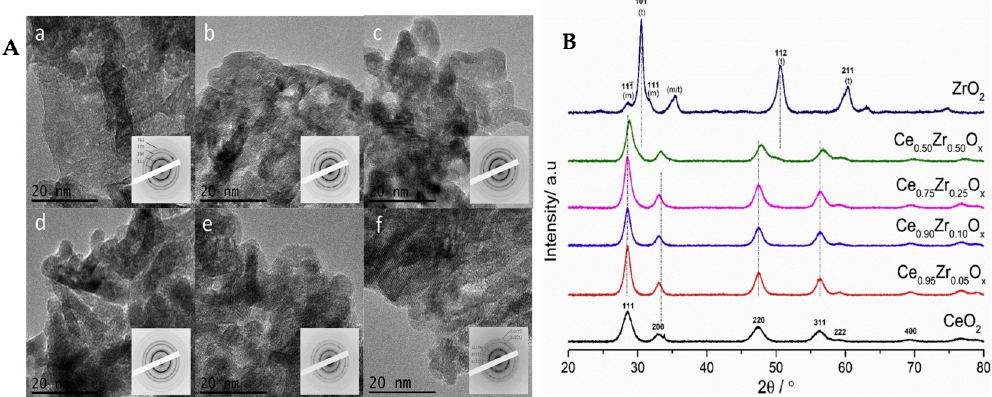
Figure 3. TEM images of ( a ) CeO 2 NPs; ( b – e ) CeZrOx (x denotes the different ratios of Ce:Zr used); ( f ) ZrO 2 ; insets are the electron diffraction pattern of the selected areas (Panel [ A ]), and the corresponding XRD pattern (Panel [ B ]). (Reproduced with the permission from Ref. [102]. Copyright © 2019 Elsevier B.V. All rights reserved.)